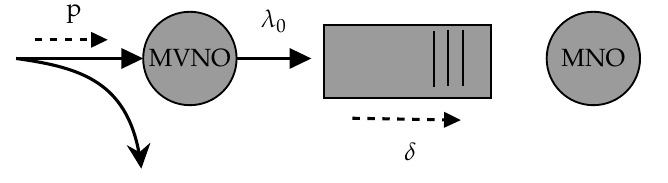
Figure A1. System